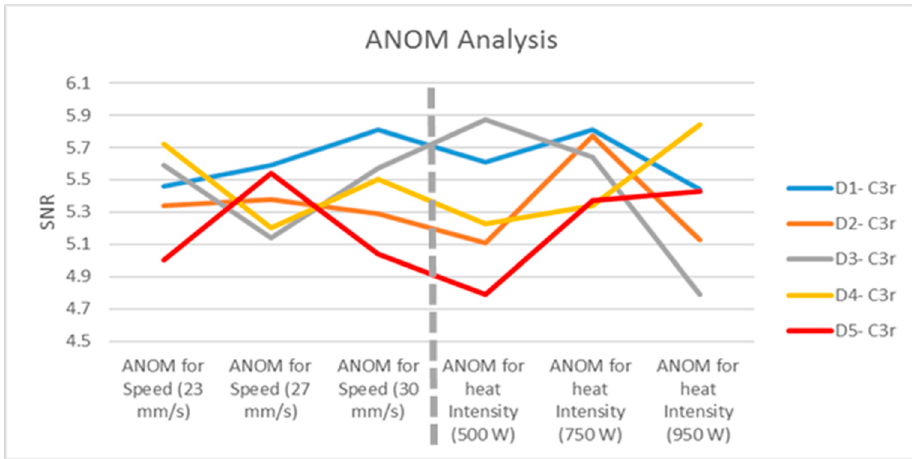
Figure 14. Graphical representation for the ANOM values for the all the defects in one quadrant.